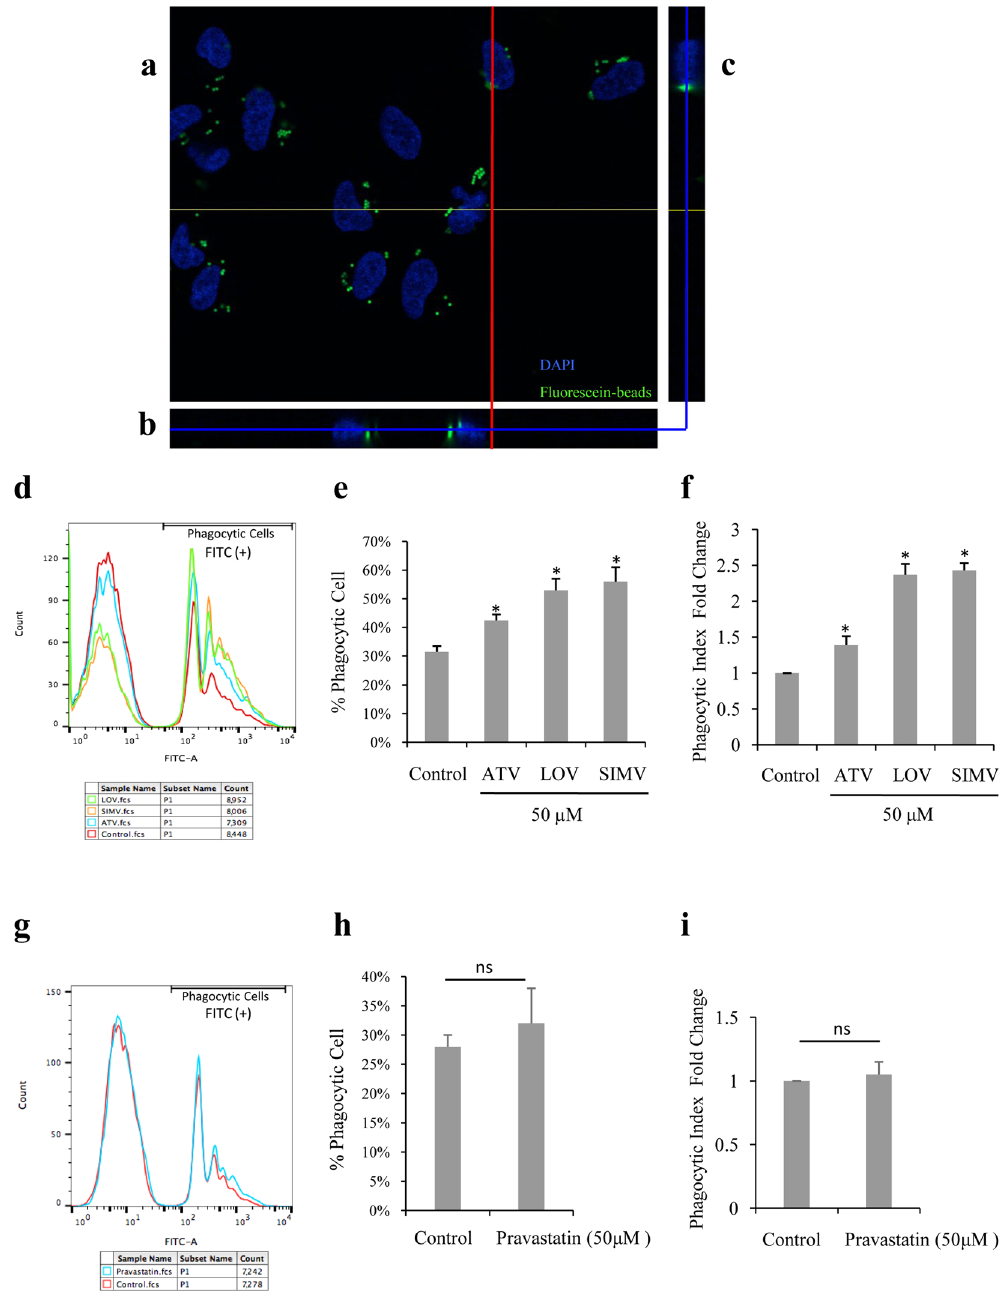
Figure 1. Lipophilic statins increase the phagocytic function of ARPE-19 cells. ( a – c ) ARPE-19 cells were incubated with polystyrene microspheres (5 × 10 7 beads/ml) for 6 hours and then imaged by confocal microscopy collecting a stack of 50 images. ( a ) A confocal stack showing fluorescein-labeled beads (green) inside ARPE-19 cells, located proximal to DAPI-labeled nuclei (blue). The depth of image A within the stack is indicated by blue lines in ( b ) and ( c ). ( b ) A view through the same stack at the place denoted by the yellow line in ( a ). ( c ) A view through the same stack at the place denoted by the red line in ( a ). ( d , g ) Count of phagocytic cells (Y axis), represented by number of FITC-positive cells, and fluorescence intensity (X axis), as determined by flow cytometry of ARPE-19 cells incubated with fluorescein-labeled carboxylate microspheres and treated with different statins. (e , h ) Quantification of the percentage of phagocytic cells shown in ( d ) and ( g ) separately. ( f , i ) Quantification of the fold change of phagocytic index (or mean fluorescence intensity). The results are expressed as mean ± SE. * p < 0.05 versus control